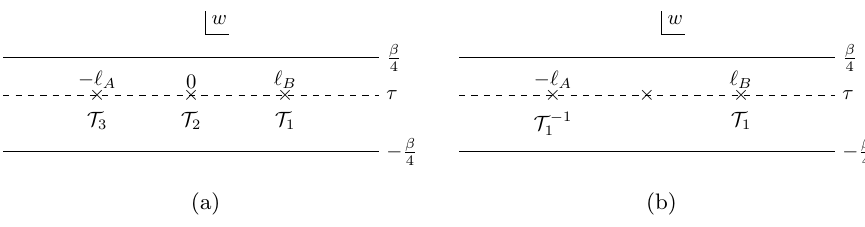
Figure 4 . Locations of the twist (cid:12)eld in an in(cid:12)nite stripe. (a) The correlation function of the numerator in eq. (2.6) (b) The correlation function of the denominator in eq. (2.6). ( (cid:28) ) are de(cid:12)ned by the upper and lower portion of the Euclidean j i